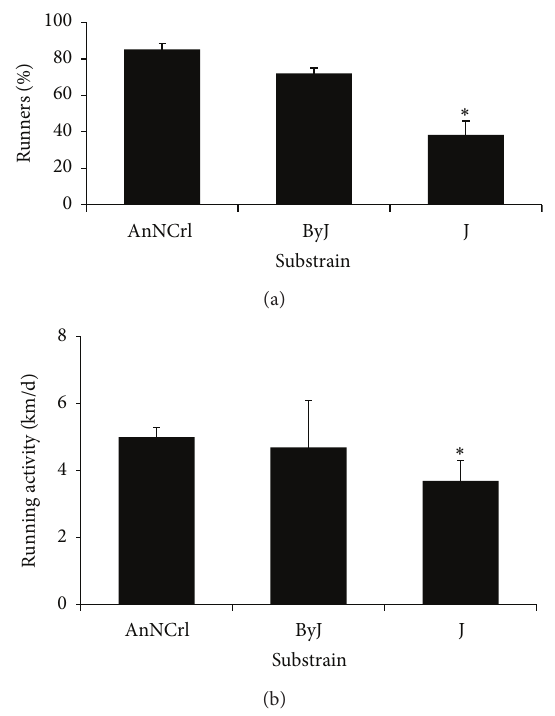
Figure 1: Different mouse substrains show differential physical activity as a behavior. Seven-week-old female BALB/c mice, belong- ing to three different substrains as indicated, were individually placed in wheel equipped cages. The running behavior (a) and the daily distance covered (b) were recorded for four days. The average ± SEM of at least three independent experiments, each one performed at least in quadruplicate, is shown. BALB/c J mice run significantly lessthantheothertwosubstrainsandthemajorityofthispopulation do not show at all interest for wheel running. (a) ∗ P < 0.01 by Tukey HSD test versus AnNCrl or versus ByJ. (b) ∗ P < 0.05 by Sutdent’s t -test versus AnNCrl.